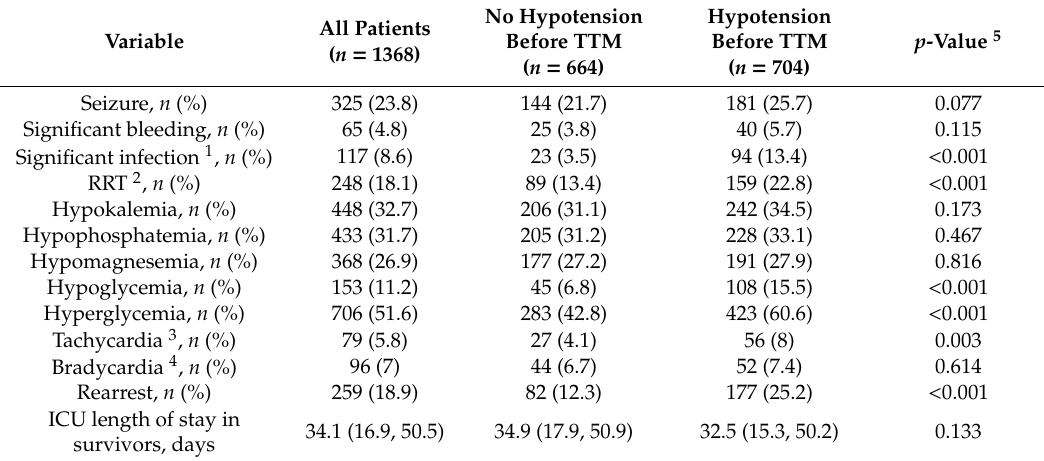
Table 2. Comparison of complications and the length of ICU stay according to the timing of hypotension